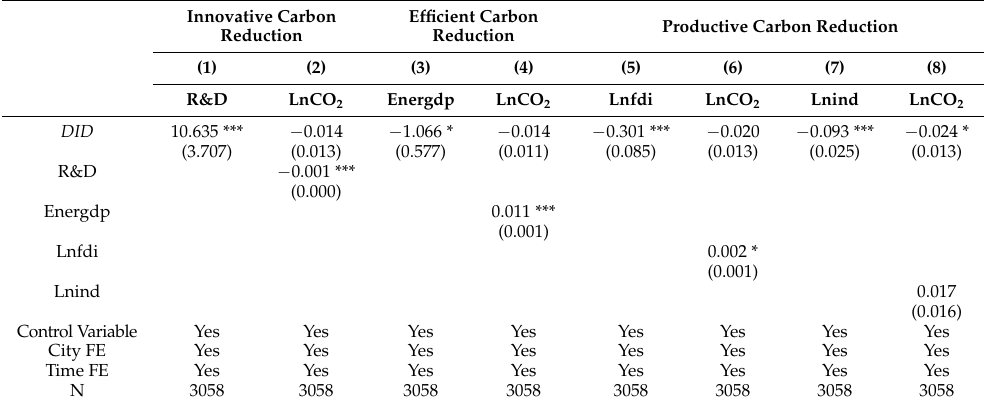
Table 11. Mechanism testing.